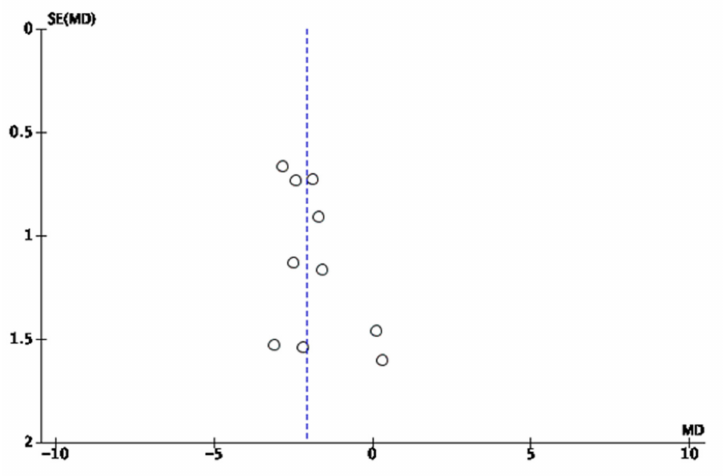
Figure 4. Funnel plot of comparison: insomnia intervention versus control